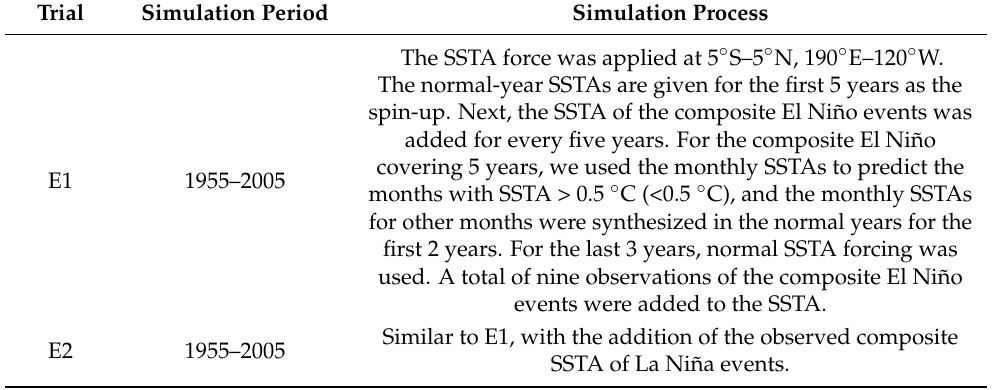
Table 1. Simulation experiment